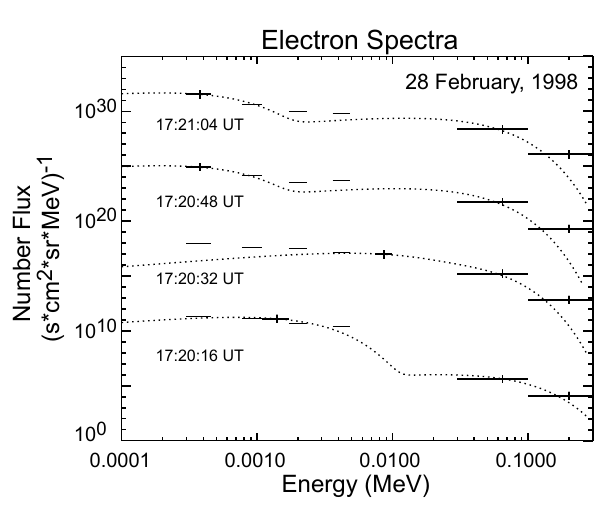
Fig. 3. Energy spectra of precipitating electrons measured by NOAA 12 at four selected times, indicated by the vertical dotted lines in Fig. 2a. The thick horizontal lines show the electron flux used to estimate the energy spectrum and the dotted curves have a double Maxwellian fit to the measurements. The thin horizon- tal lines are measurements from four energy channels of the TED, which were sampled every 8s and were not used to estimate the spectra. The spectra are displaced from one another by 7 orders of